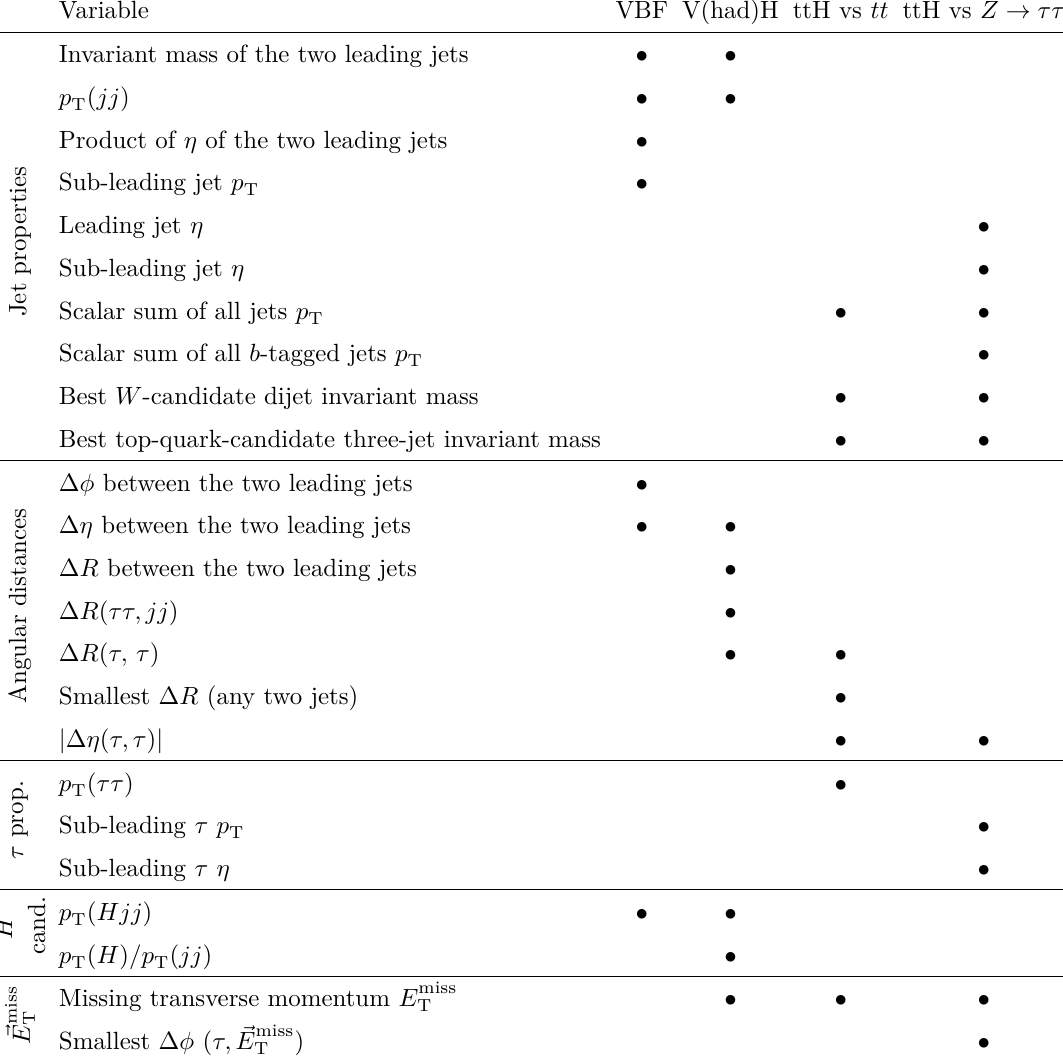
Table 5. Variables used in the four multivariate taggers employed in the analysis. For each tagger, the presence or absence of a • indicates whether the variable is used or not. The symbol τ stands for any reconstructed τ -lepton candidate (electron, muon or τ The symbols ττ and jj indicate the vectorial sums of the momenta of two visible τ -lepton candidates and of the two leading jets, respectively. The Higgs boson candidate H is formed by the vector sum of the two τ -lepton candidates’ momenta and ~E miss non- b -tagged jets in the event with invariant mass closest to m as the system of the W candidate and a b -tagged jet in the event with invariant mass closest to m